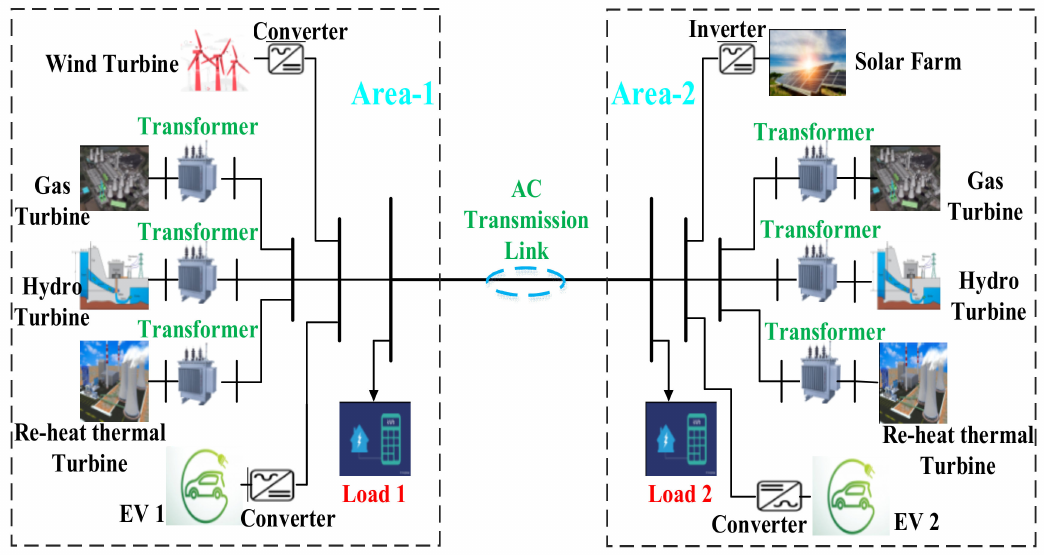
Figure 1. The studied power grid schematic